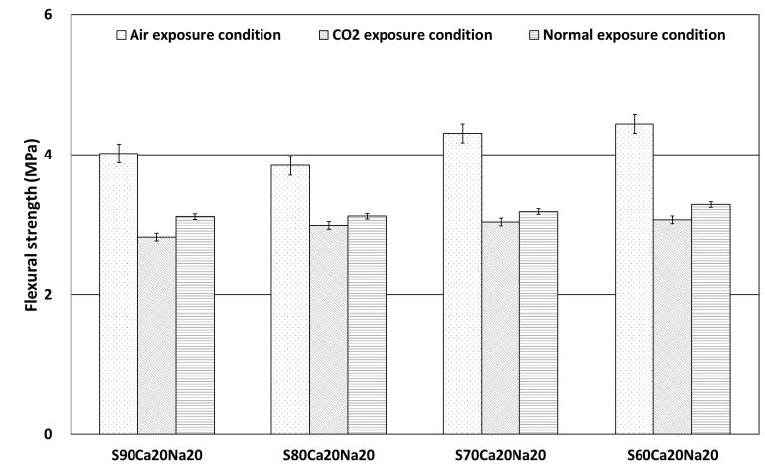
Figure 5. Flexural strength experiment results (7 days of age).